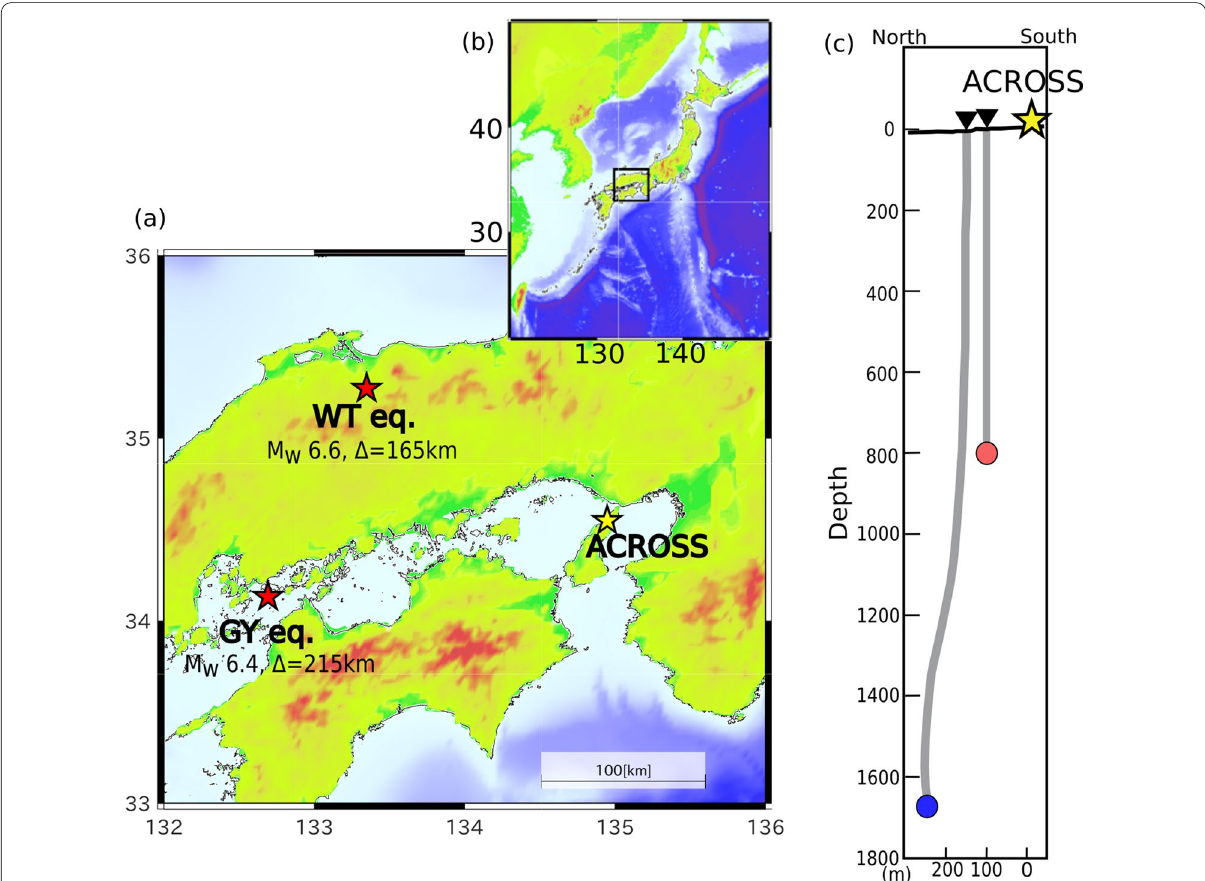
Fig. 3 Location of ACROSS vibrators and borehole seismometers. a Location of the site where ACROSS was deployed (yellow star) and epicenter of two earthquakes, which are mentioned in the text (red stars). The area of the map ( a ) is indicated by a black square in map ( b ). c Location of the ACROSS vibrator and borehole seismometers on a vertical cross section. The yellow star indicates the ACROSS vibrator. The red and blue circles show the 800-m and 1700-m sensors,